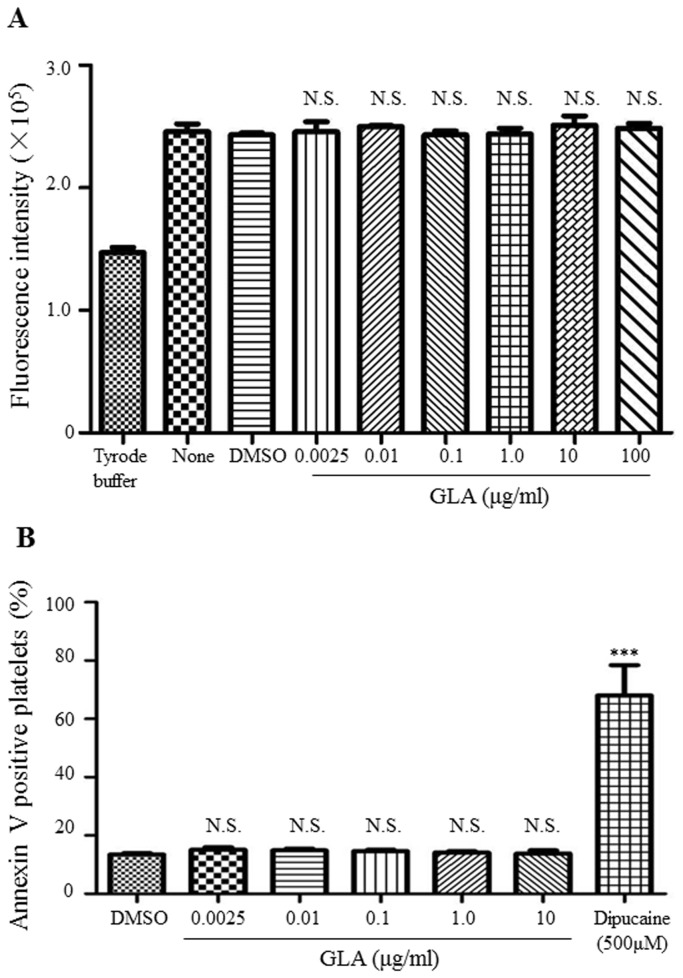
Evaluation of the potential toxic and apoptotic effect of GLA on platelets.(A) In platelet viability assay for the toxic effect of GLA, gel-filtered platelets (2.5×108/ml) were preincubated with GLA (0.0025-100μg/ml) or vehicle and then incubated with Alamar Blue reagent for 4 hours at 37°C. The fluorescence was acquired with the excitation and emission wavelengths of 570 nm and 585 nm, respectively, and plotted in the bar charts (mean ± standard error, n=3). (B) In PS externalization assay, gel-filtered platelets (2×107/ml) were preincubated with GLA (0.0025-10μg/ml) or vehicle or dibucaine (500μmol/Lol/L) at 37°C for 15 min, and then mixed with Annexin V binding buffer and Annexin V-APC. Samples were analyzed by flow cytometry and the percentage of annexin V positive platelets was calculated (mean ± standard error, n=3). ***P<0.001. N.S., not significant compared to vehicle control. The statistical significance was determined by one-way ANOVA analysis of variance with the Bonferroni post test.